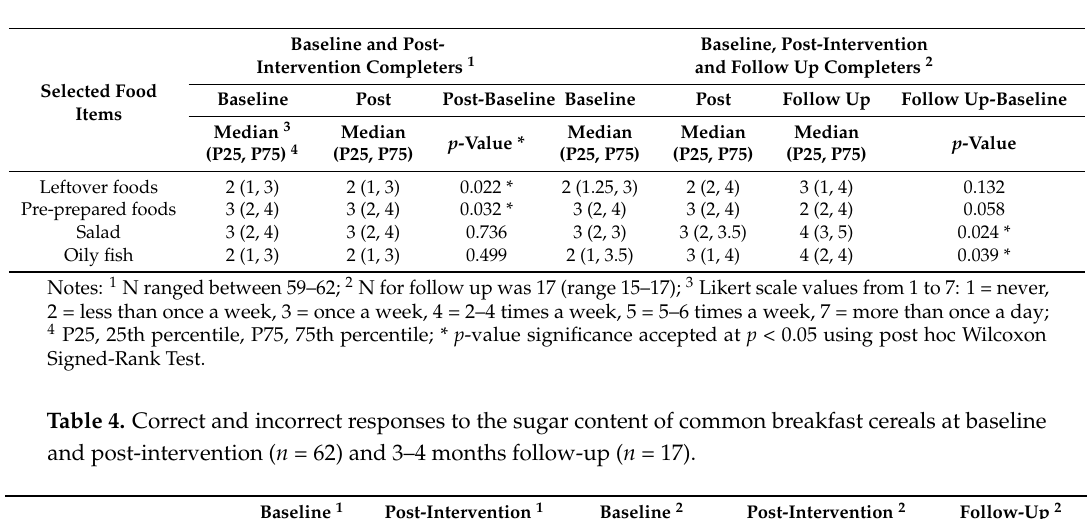
Table 3. Median values for the frequency of consumption of certain foods at baseline and post-intervention ( n = 62) and 3–4 months follow-up ( n = 17).